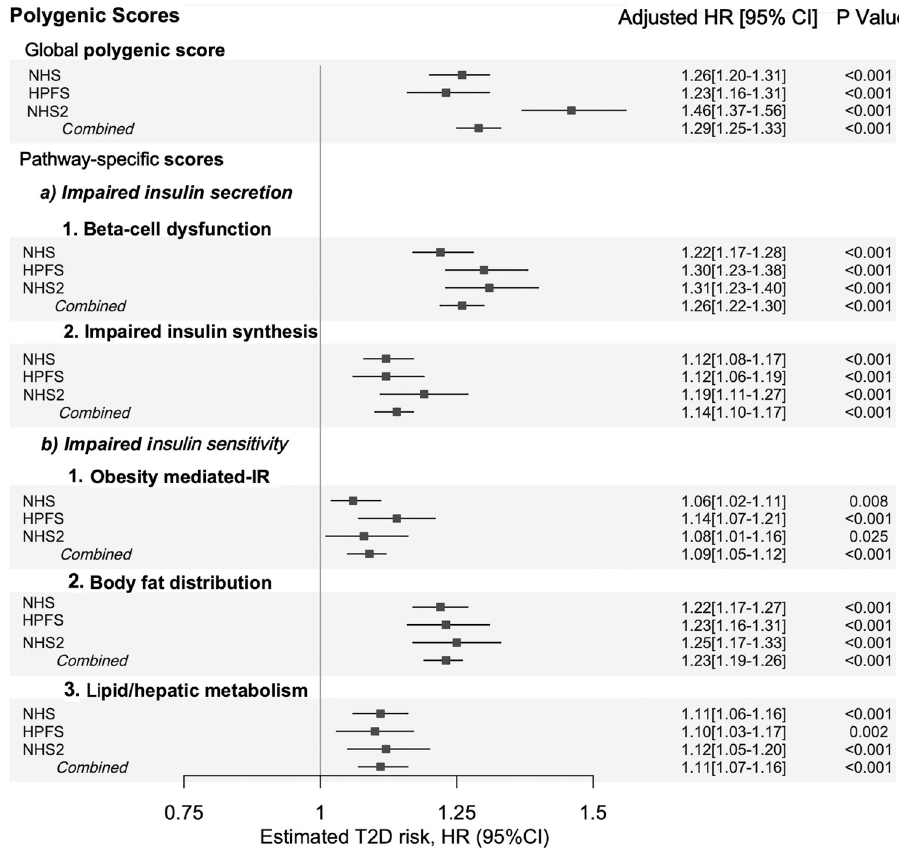
Fig 1. Risk of incident type 2 diabetes associated with genetic risk. Shown are adjusted HRs and 95% CI of the estimate for type 2 diabetes risk per SD increase in polygenic scores. Estimates are presented for each of the 3 prospective cohorts separately and in a combined analysis. Polygenic scores included in this study are described in the methods section. Cox proportional hazards models were stratified by age and adjusted for ancestry-derived principal components, family history of diabetes, history of hypertension, history of hypercholesterolemia, menopausal status (women only), BMI, smoking status, physical activity, and total energy intake. Fixed-effects inverse variance weighted meta-analysis was used to combine cohort-specific results. B AU : TheabbreviationlistofFig 1 hasbeenupdated : Pleaseverifythatallentriesarecorrect : MI, body mass index; CI, confidence interval; HPFS, Health Professionals Follow-up Study; HR, hazard ratio; IR, insulin resistance; NHS, Nurses’ Health Study; NHS2, Nurses’ Health Study II; SD, standard deviation; T2D, type 2